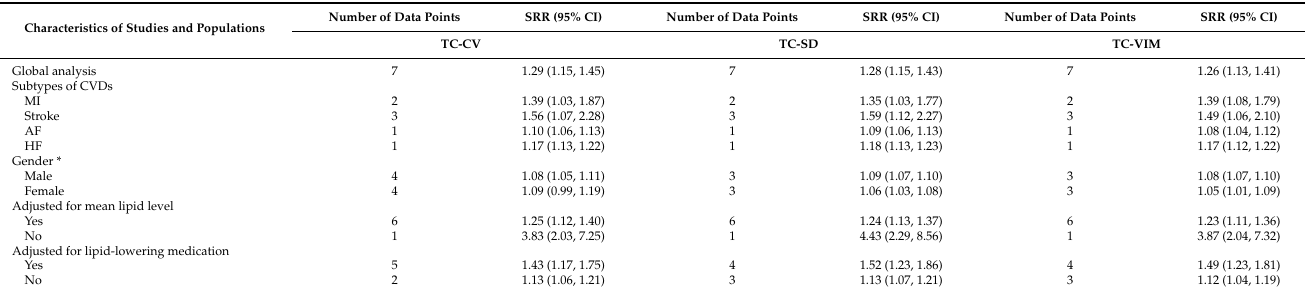
Table 2. Summary effects and 95% CI using random-effects subgroup meta-analysis for the associa- tions of TC variability (top vs. bottom quartile) with